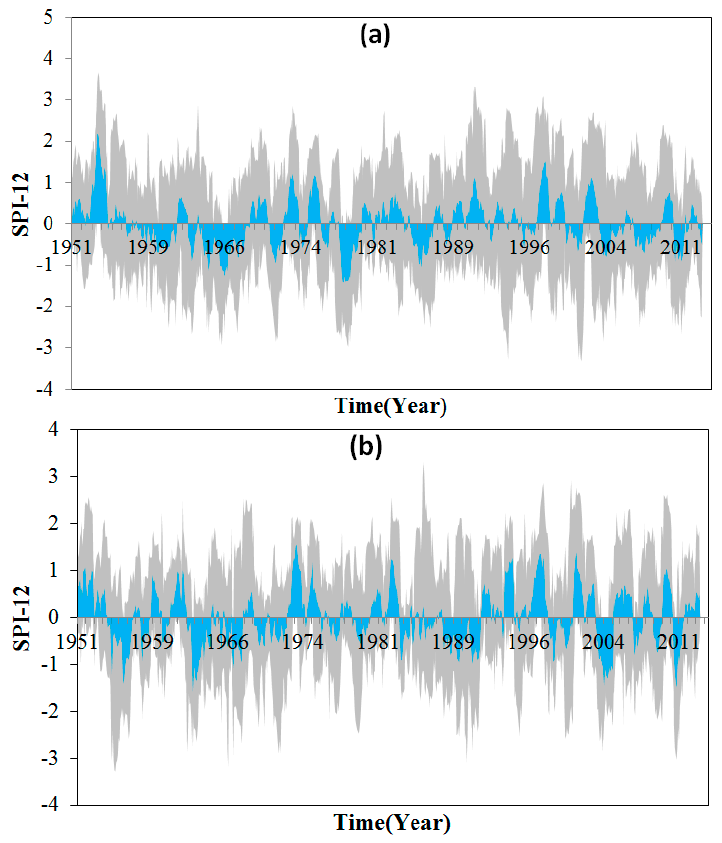
Figure 3. The SPI values for 1951–2013 for ( a ) MLRY and ( b ) South areas.